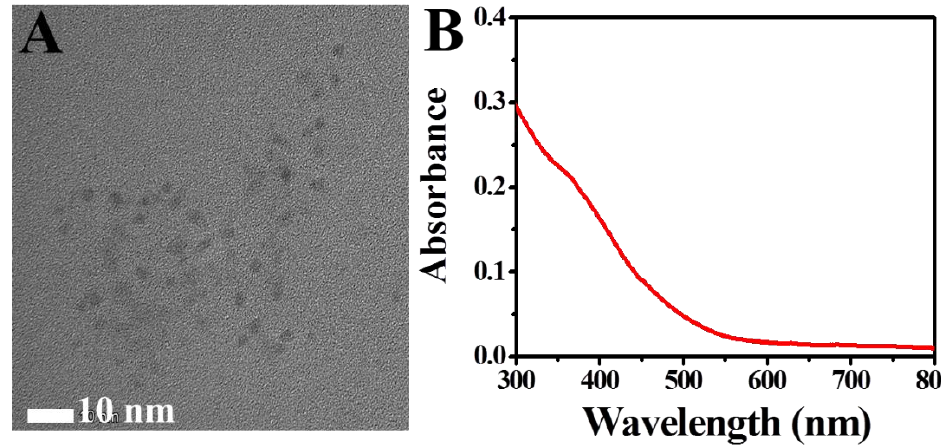
Figure 1. ( A ) TEM images of CP and ( B ) UV absorption peaks of CP.